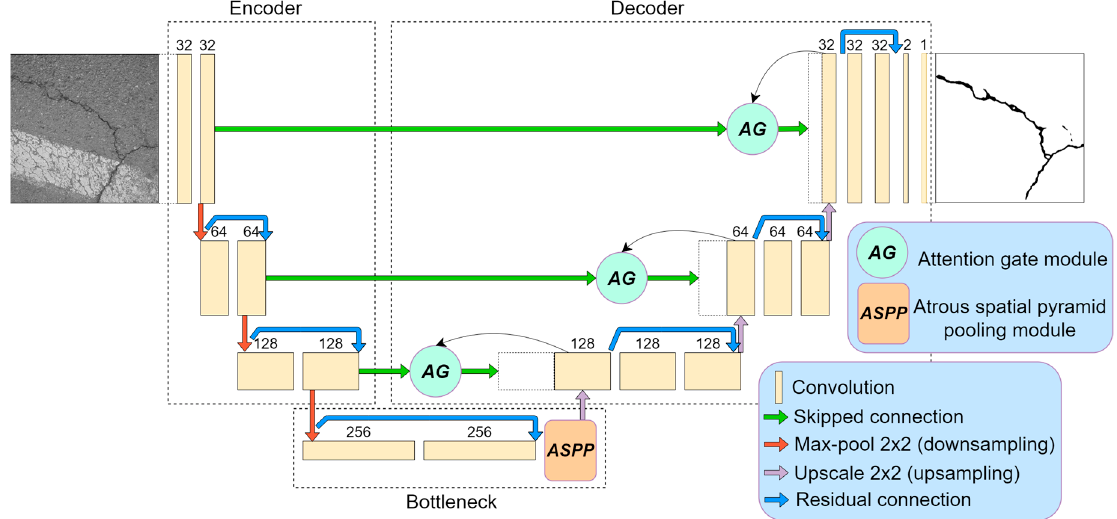
Figure 3. U-Net neural network with few modifications: residual connection, atrous spatial pyramid pooling (ASPP), and attention gate (AG) modules.